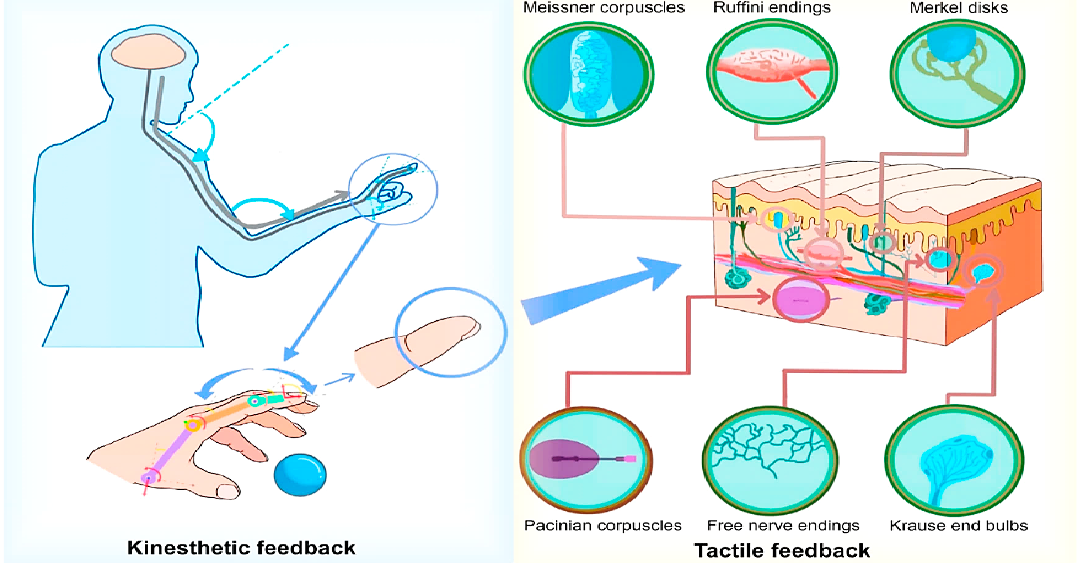
Figure 3. Kinesthetic ( left ) and tactile feedback ( right )are shown in a schematic depiction of haptic feedback. The awareness of muscles and joints in response to a gesture, stretch, weight, etc., is known as kinesthetic feedback. The sense of surface hardness, temperature, and other properties of the skin’s surface derived through mechanoreceptors is known as tactile feedback.